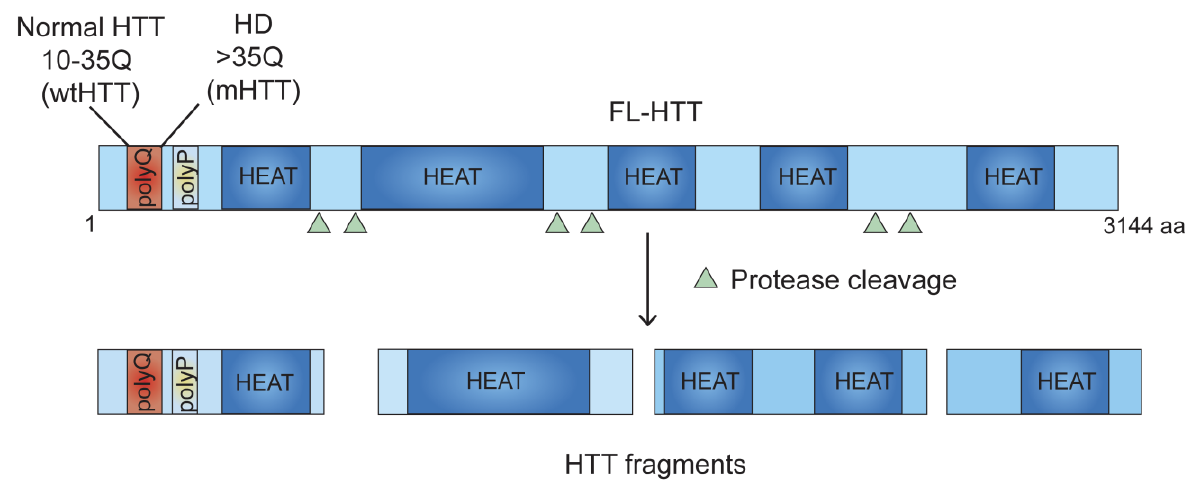
FIGURE 1: Domain structure of HTT protein. HTT consists of 3144 amino acids (aa). PolyQ-polyglutamine tract; polyP-proline-rich domain; HEAT repeats are shown. polyQ and polyP may regulate protein-protein interaction. HEAT repeats may act as scaffolding domain for tether- ing, localizing, and coordinating the functions of the proteins involved in ribosome elongation, thereby controlling the movement of ribo- somes. polyQ expansion in HTT (mHTT) inhibits the movement of ribosomes causing stalling of the polyribosomes. HTT undergoes proteolytic cleavage and generates HTT fragments that may also regulate ribosome movements. Triangle depicts approximate location of protease cleavage